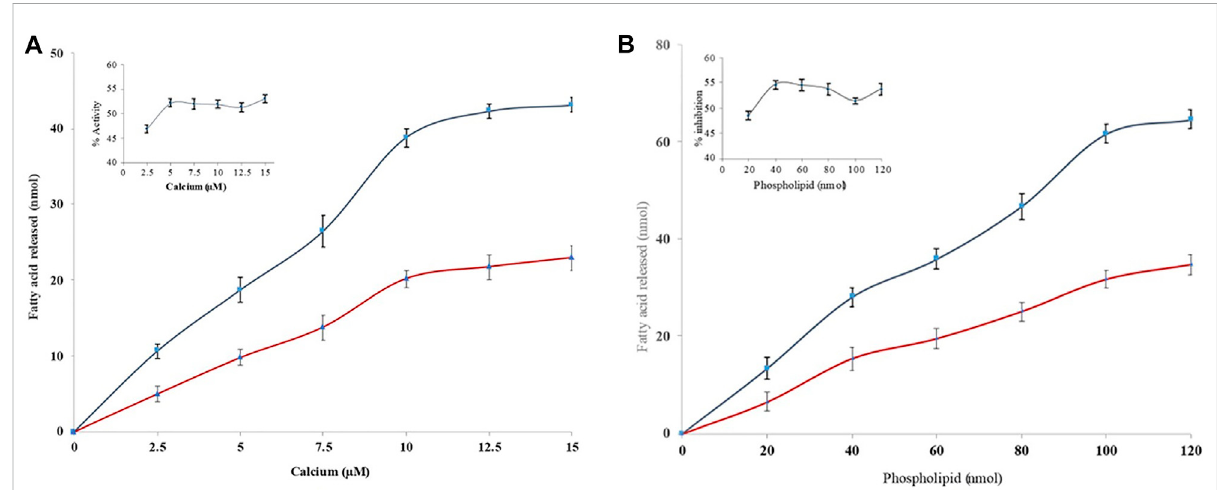
FIGURE 3 Effect of calcium and substrate concentration on sPLA 2 IIa inhibition. (A) sPLA 2 IIa activity without quercitrin (blue line) and with quercitrin (red line) with the indicated concentrations of calcium (2.5 – 15 µM). (B) sPLA 2 IIa activity without quercitrin (blue line) and with quercitrin (red line) by increasing the substrate concentration from 20 to 120 nM. The data are expressed as mean ± standard deviation ( n =